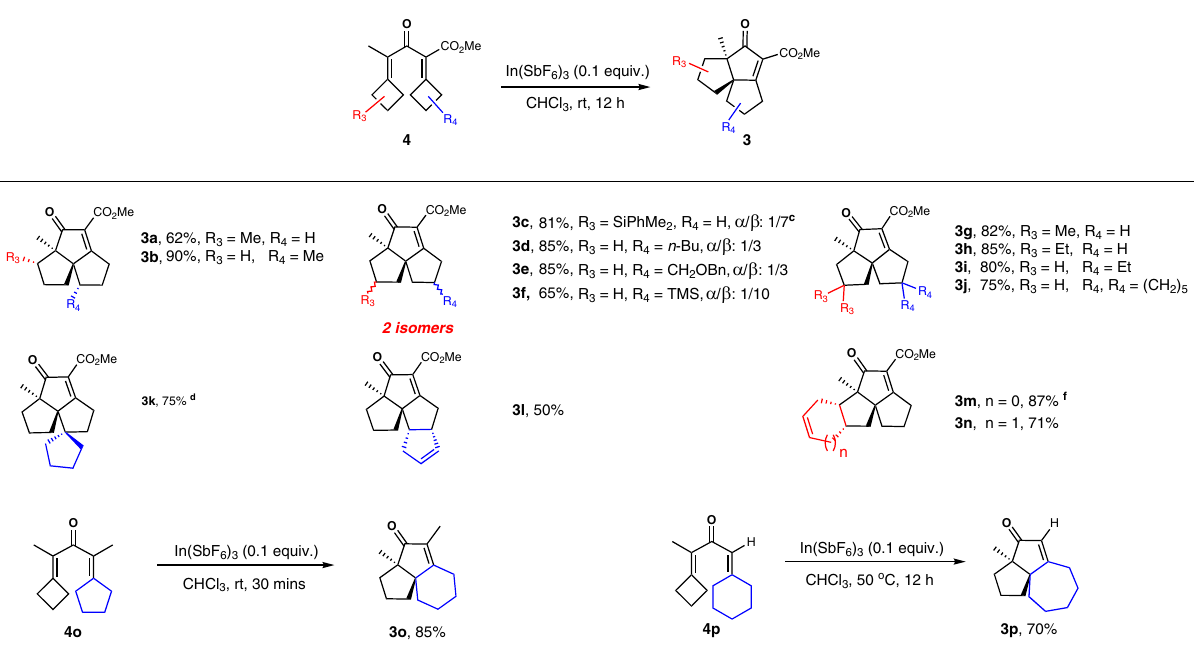
Fig. 3 Substrate scope expansion by varying substitution (R 3 and R 4 ) at cyclobutyls (a, b, e). ( a ) Reactions were carried out at rt with 0.1 mmol of 4 in 1.0 mL CHCl 3 for 12 h. ( b ) Isolated yields. ( c ) Reaction at − 10 °C with DCM/HFIP (1:1) as solvent, with 0.6 equiv NaBArF as additive. ( d ) Reaction at 50 °C. e Unless noted, dr > 20:1. f Determined by XRD.